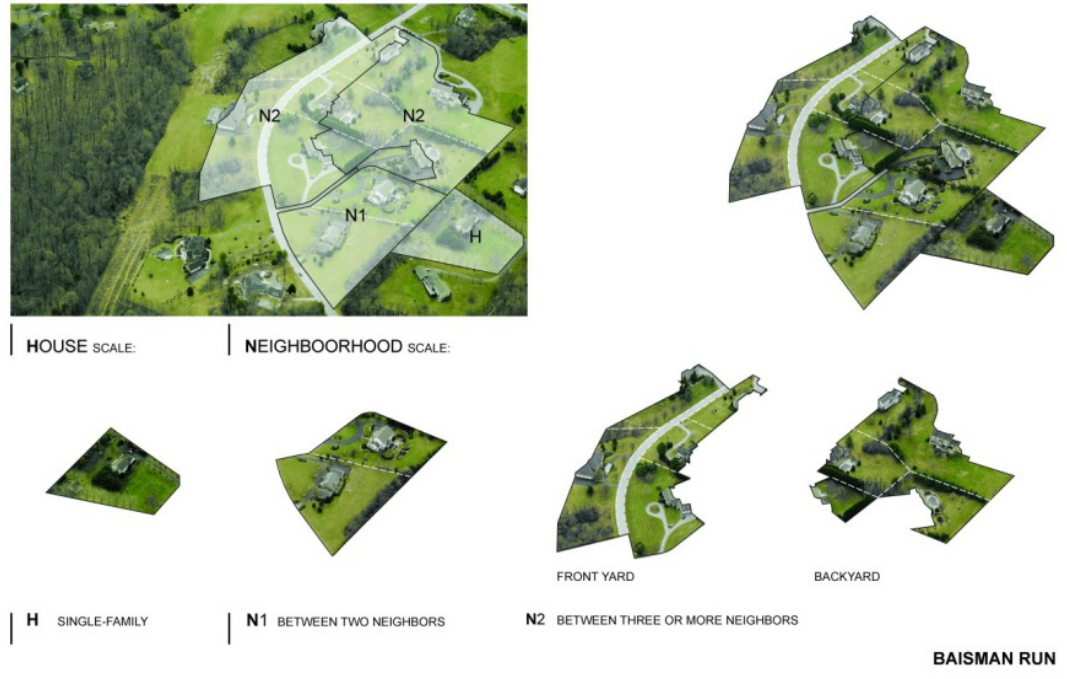
Figure 6. Vegetation and water management in Baisman Run was studied along the road right-of-way and front yards, within individual parcels, and in-between parcels. Storm water flows rapidly off the excessive paved surfaces into the headwaters of an open stream network, incising the streams and exporting nitrogen leaching from the septic